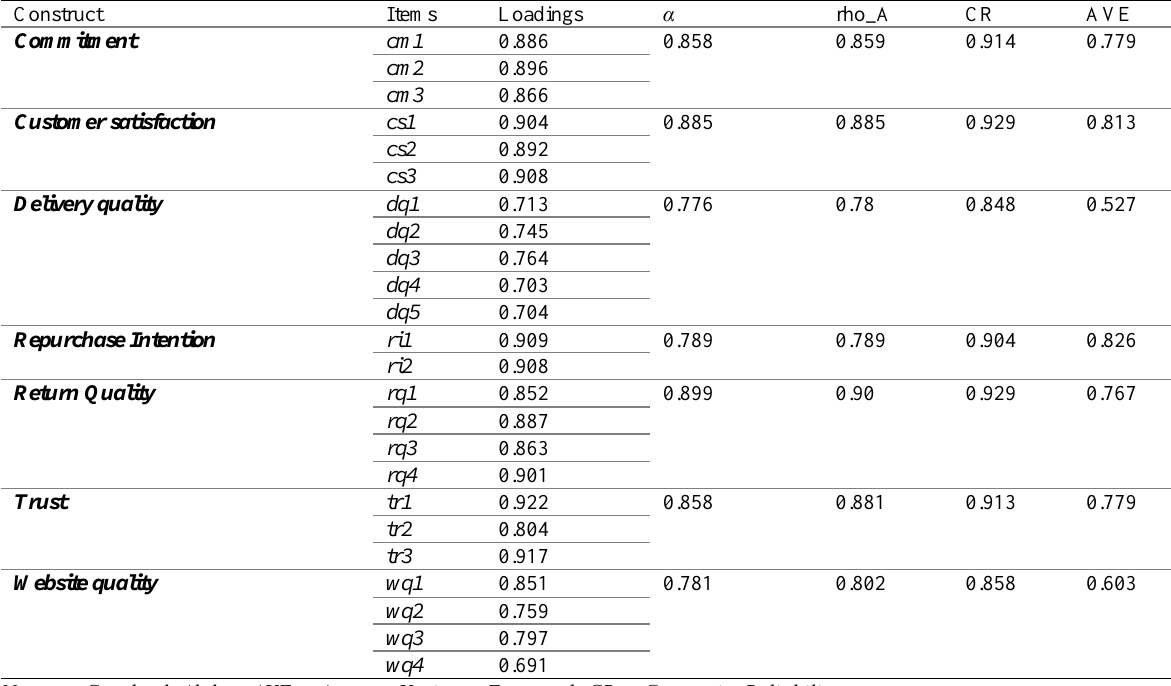
Table 2: Reliability and Construct Validity